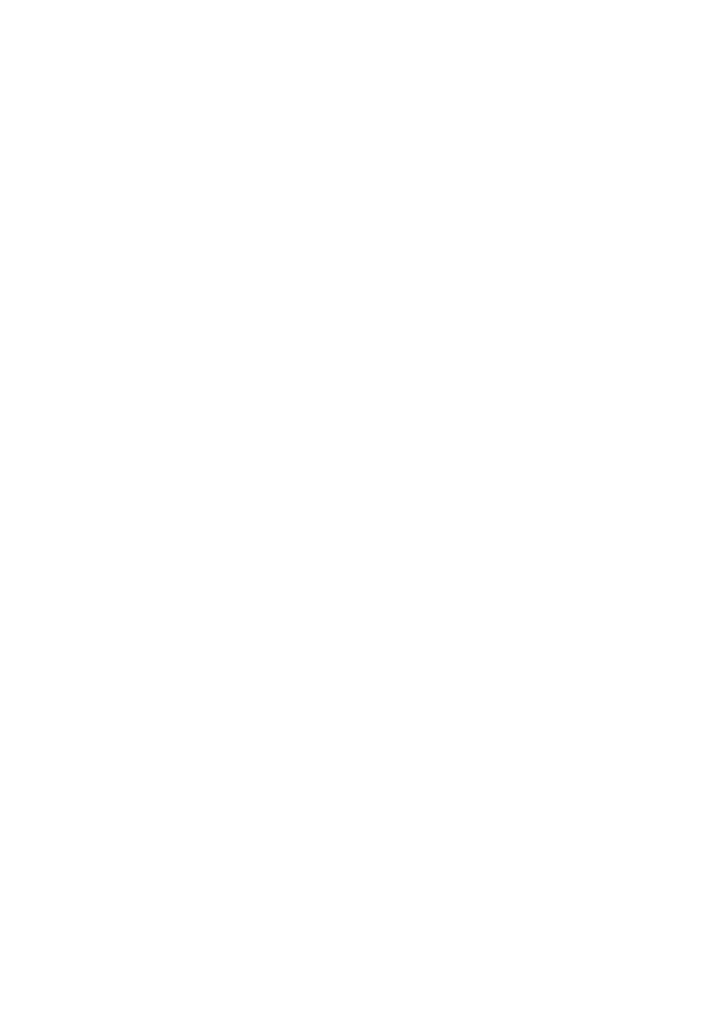
FIG. 1. Effect of DPI on IL-1-induced NO production. (A) Chondrocyte cultures were pretreated with the indicated concentrations of DPI for 2h. Then, IL-1 (20ng/ml) was added to the corresponding wells and the cells further incubated for 16h. (B) Chondrocyte cultures were treated overnight with IL-1 (20ng/ml). Then, the culture supernatant was removed and the cells washed three times with culture medium. New culture medium, containing the indicated concentrations of DPI, was added to the corresponding plates and the cells further incubated for 16h. The nitrite concentration of each sample was determined as described in Materials and methods. Each bar represents the mean ± SD of six independent experiments, each performed in triplicate. * p < 0.01 relative to IL-1.